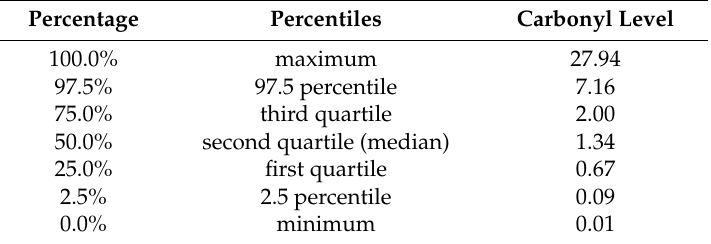
Table 4. Carbonyl levels at different percentiles of the distribution.